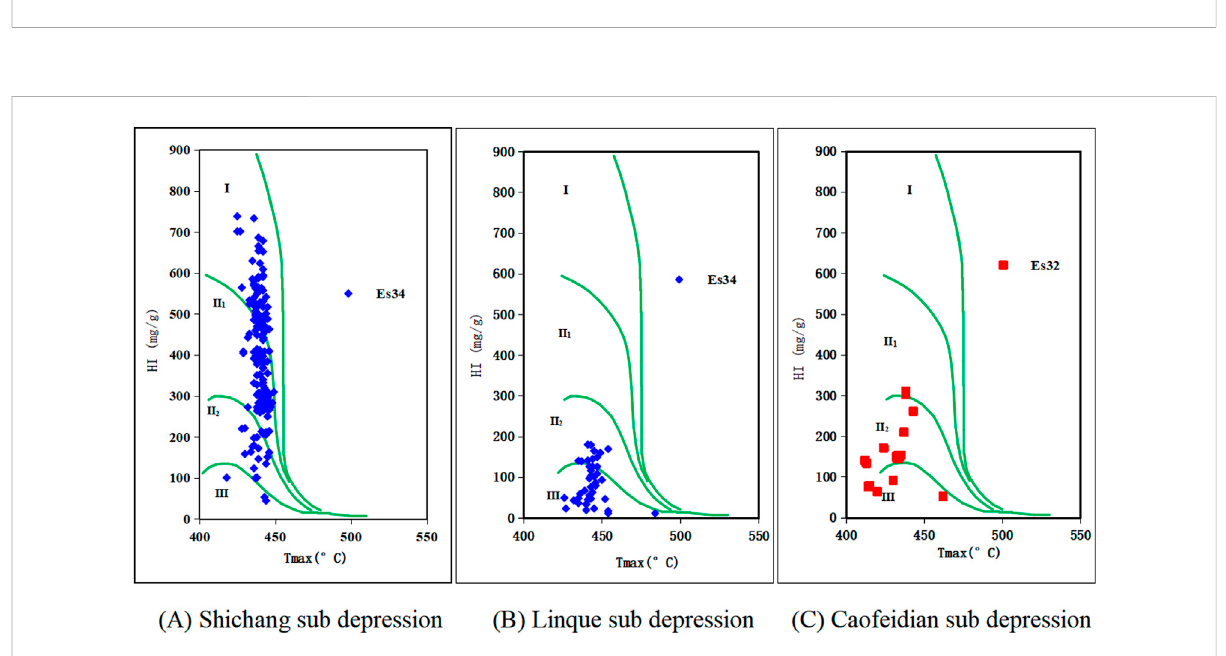
FIGURE 4 Classi fi cationoforganicmattertypesofEs 3 sourcerocksindifferentsubdepressionsofNanpuSag. (A) Shichangsubdepression. (B) Linquesub depression. (C) Caofeidian sub